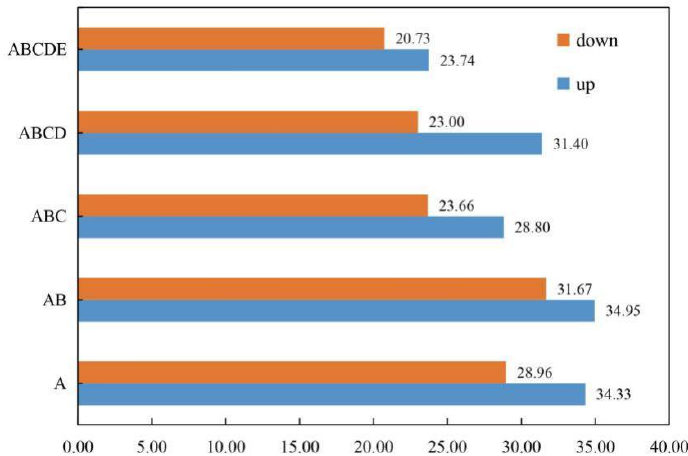
Figure 7. Venn diagram of the percentage of transcription factors downregulated on HZ2399 com- pared to SQ25 at the same time point; Horizontal coordinate: transcription factors as a percentage of differential genes (%); vertical coordinate: A: KPA vs. MPA; AB: KPA vs. MPA, and KPB vs. MPB; ABC: KPA vs. MPA and KPB vs. MPB, and KPC vs. MPC; ABCD: KPA vs. MPA and KPB vs. MPB and KPC vs. MPC, and KPD vs. MPD; ABCDE: KPA vs. MPA and KPB vs. MPB and KPC vs. MPC, KPD vs. MPD, and KPE vs. MPE.